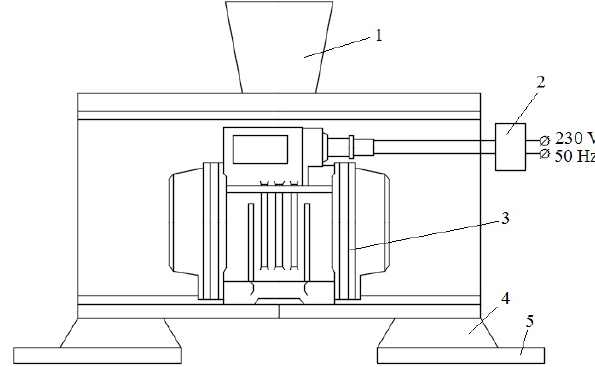
Figure 1. Schematic illustration of the vibration treatment device: 1. Casting mold; 2. Frequency converter; 3. Vibrator exciter; 4. Support; 5. Fixation system.